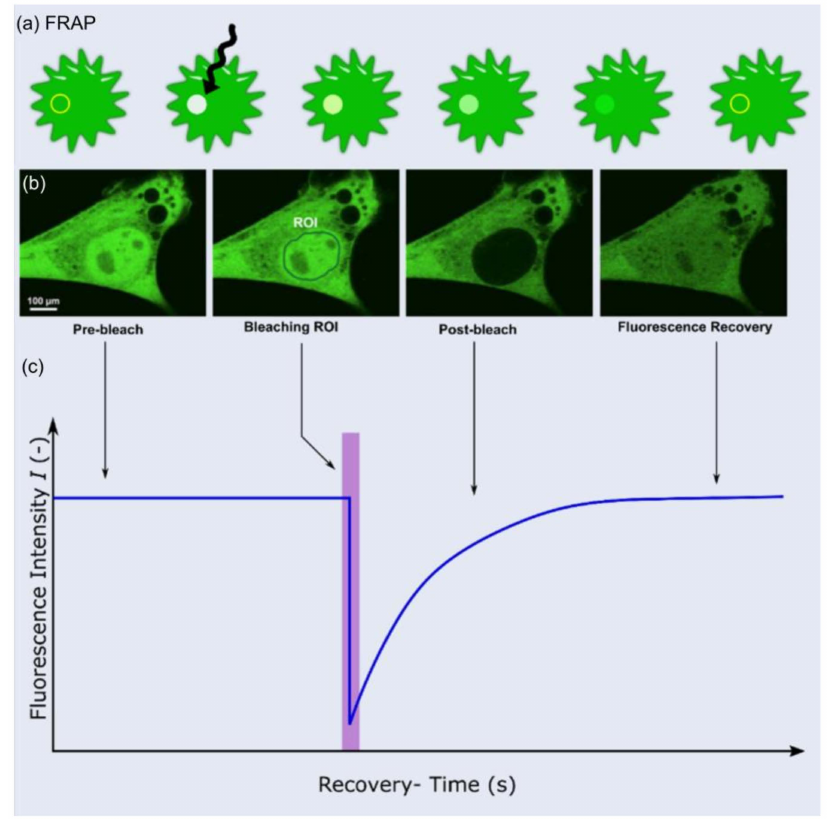
Figure 9. ( a ) Schematic representation of FRAP method, ( b ) Example of a FRAP experiment ( c ) Anatomy of a typical FRAP curve. Modified and reprinted with permission from [123] under creative commons CC BY 4.0. Copyright © 2023 by the authors; licensee MDPI, Basel,